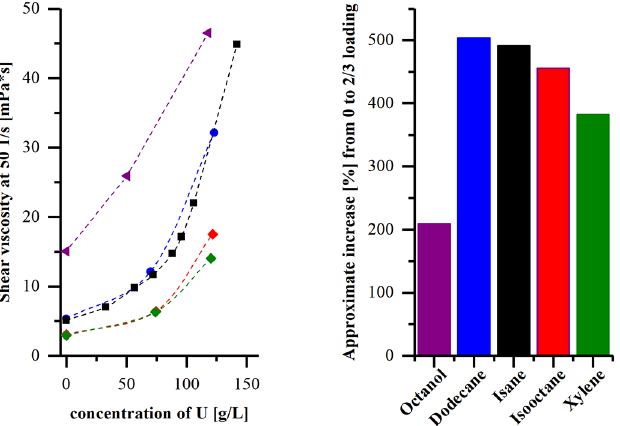
Fig. 8. Left: shear viscosities at 25 ° C dependent on diluent and uranyl concentration. Investigated system: 1.5 M DEHiBA in different diluents contacted with different aqueous phases (uranyl nitrate dissolved in 3 M nitric acid). Right: approximate viscosity increase from contact with nitric acid (0M) to 2/3 loading of the organic phase ( ≈ 0.5 M uranyl).